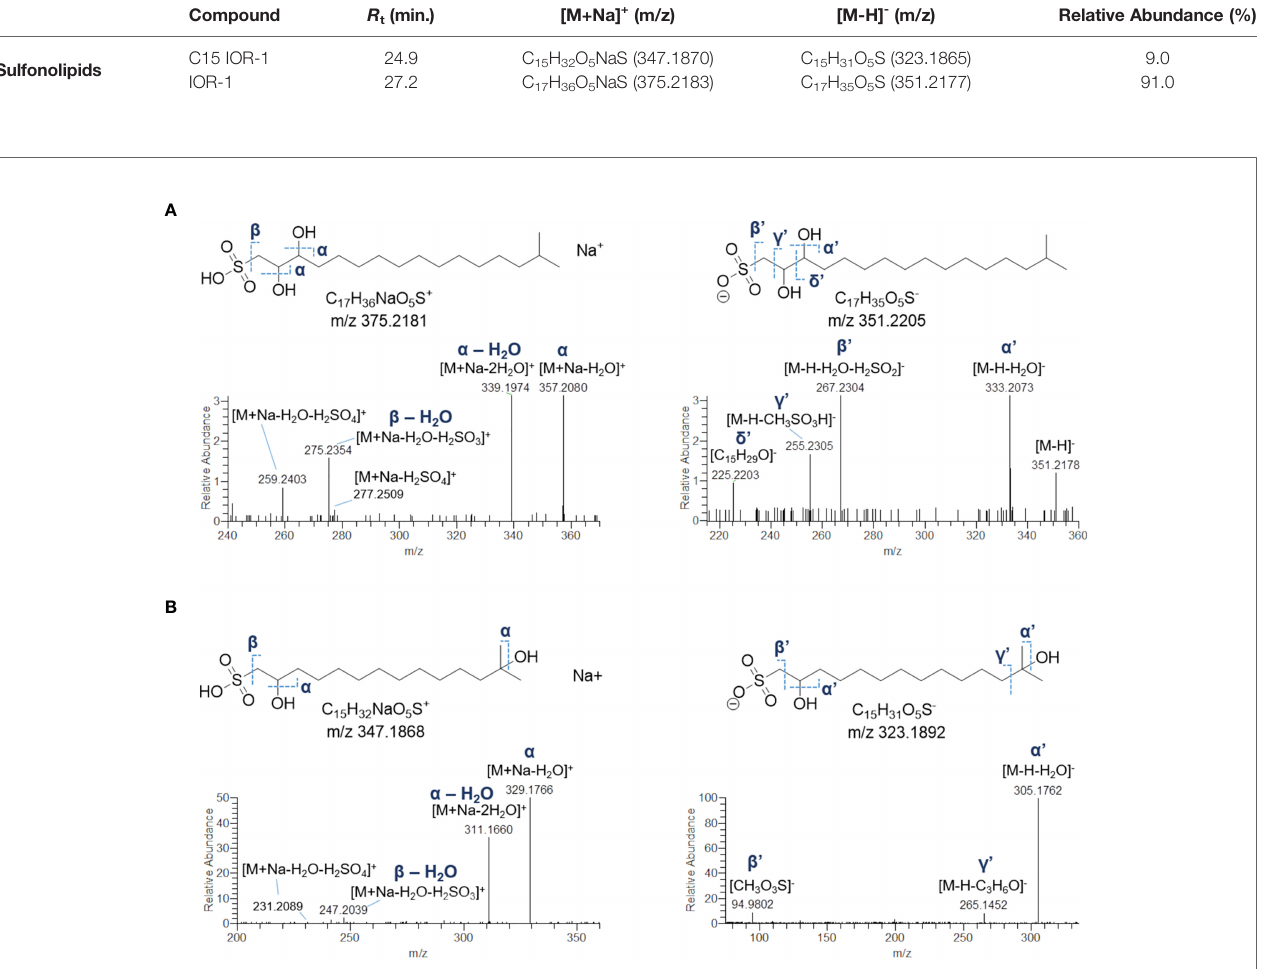
FIGURE 7 | HR ESI-MS 2 spectrum of the [M+Na] + (left panel) and [M-H] - (right panel) ions of the putative sulfonolipid from Botrylloides niger annotated as IOR-1 (A) . Predicted structure and HR ESI-MS 2 spectrum of the [M+Na] + (left panel) and [M-H] - (right panel) ions of the putative sulfonolipid C15 IOR-1 (B)